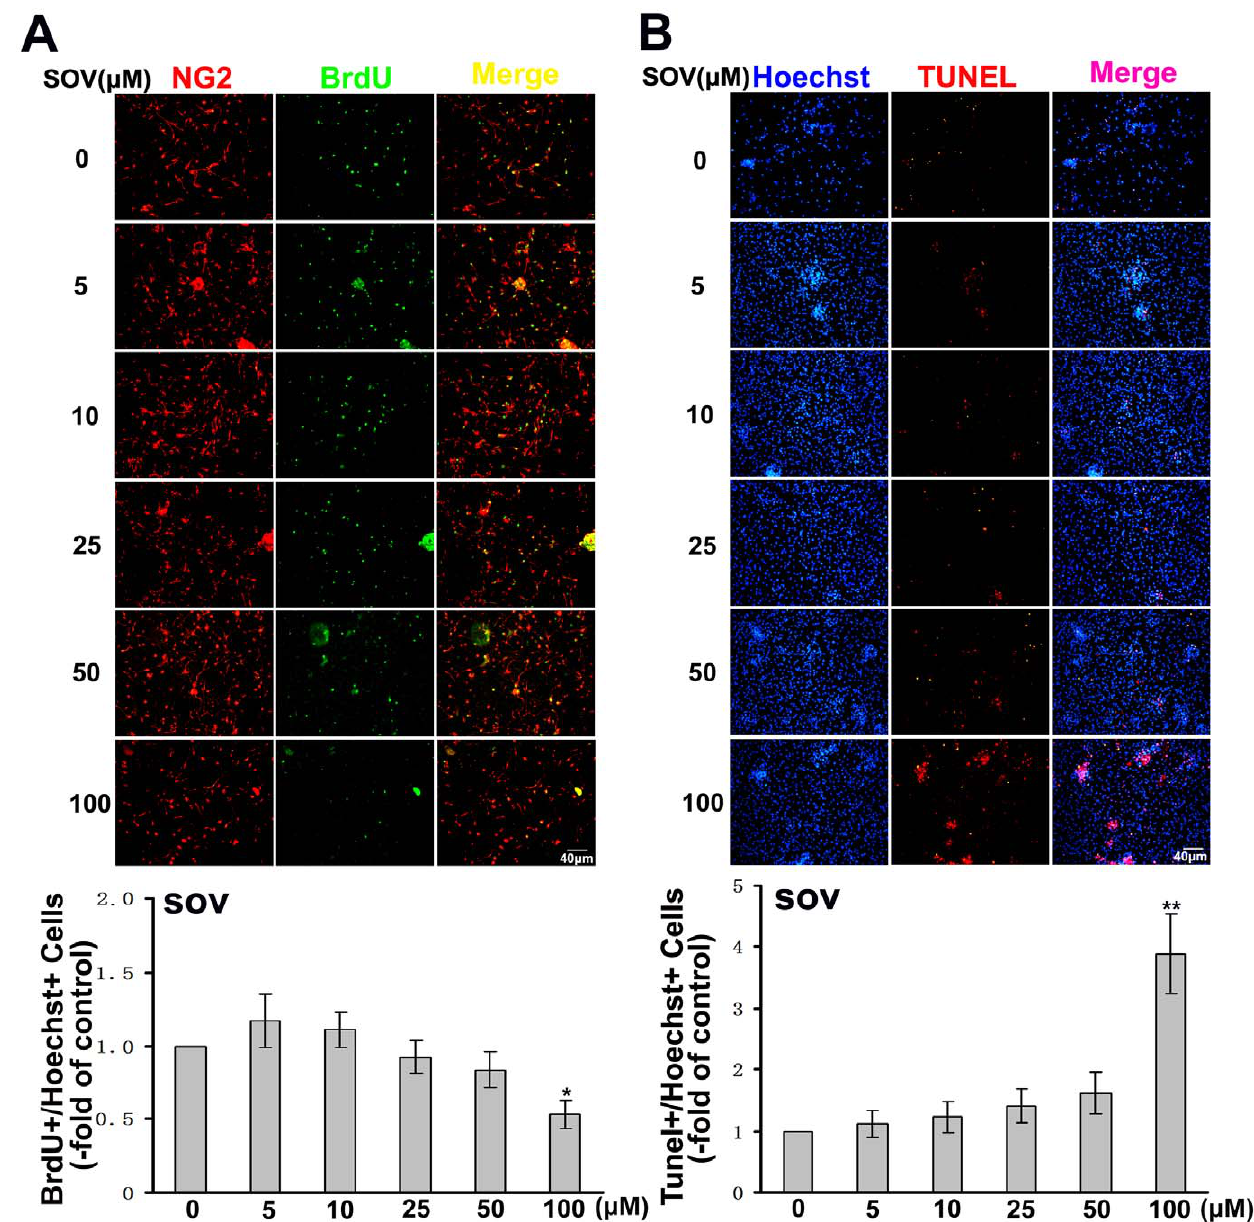
Figure 3. The effect of SOV on proliferation and apoptosis of the OPCs in vitro. ( A ) The primary cultures of OPCs were placed on PLL- coated dishes and cultured in different concentrations of SOV for 8 h with 10 m M BrdU. Proliferated cells were labeled with anti-BrdU (green), and cells were labeled with NG2 antibody (red). The culture without SOV was used as control and quantification was presented as fold of control. Ratio of BrdU-labeled cells was calculated. Data shown are the mean 6 S.D. of three independent experiments. * P , 0.05 vs controls. ( B ) Apoptotic cells were detected by TUNEL staining (red), and total number of cells was detected with Hoechst staining (blue). The culture without SOV was used as control and quantification was presented as fold of control. Ratio of TUNEL-labeled cells was calculated. Data shown are the mean 6 S.D. of three independent experiments. ** P , 0.01 vs controls.